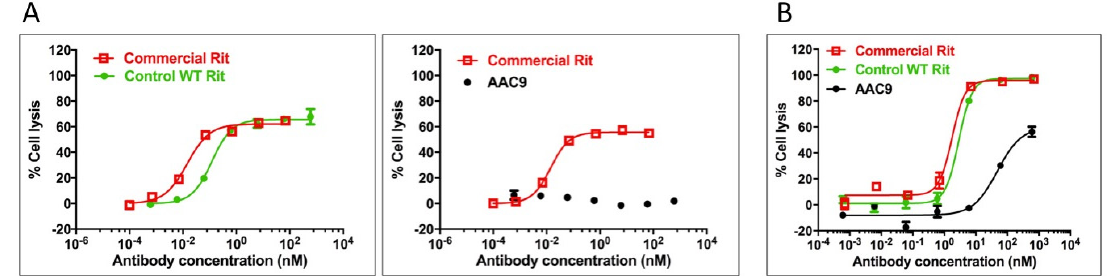
Figure 5. Ability of variants AAC9 to mediate ADCC ( A ) or CDC ( B ) against Daudi cells compared to controls including commercially available rituximab. An interpolated symmetrical sigmoidal shape is shown for Rituximab (see Supplementary Table S2 for values derived from the fit). There was no convergence for AAC9. The error bars represent the standard error of the mean. For some points, the error bars would be shorter than the height of the symbol. In these cases, error bars are not drawn.